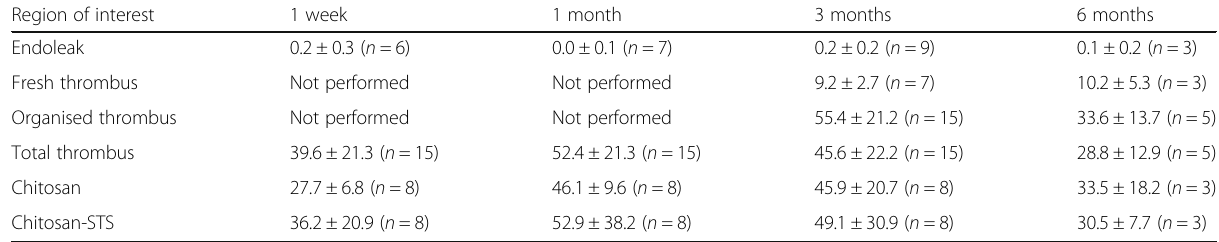
Data are kPa expressed as mean±standard deviation. n indicates the number of